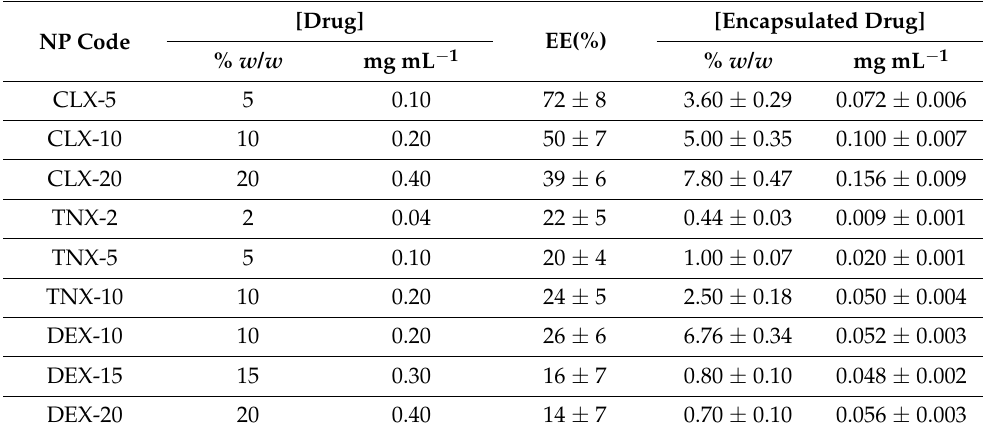
Table 2. Concentrations of feed and encapsulated drugs in NP suspensions (2.00 mg mL − 1 ) in terms of % w / w with respect to the terpolymer and mg mL − 1